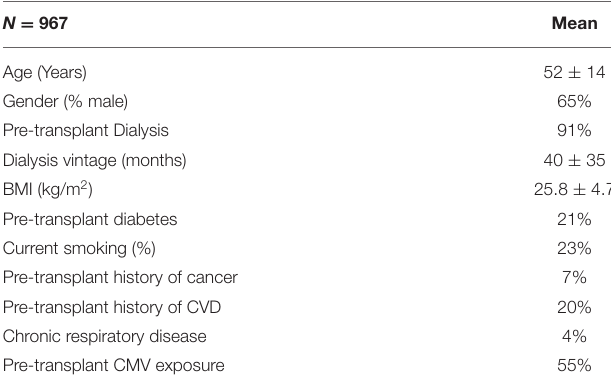
TABLE 1 | Demographic characteristics of the study